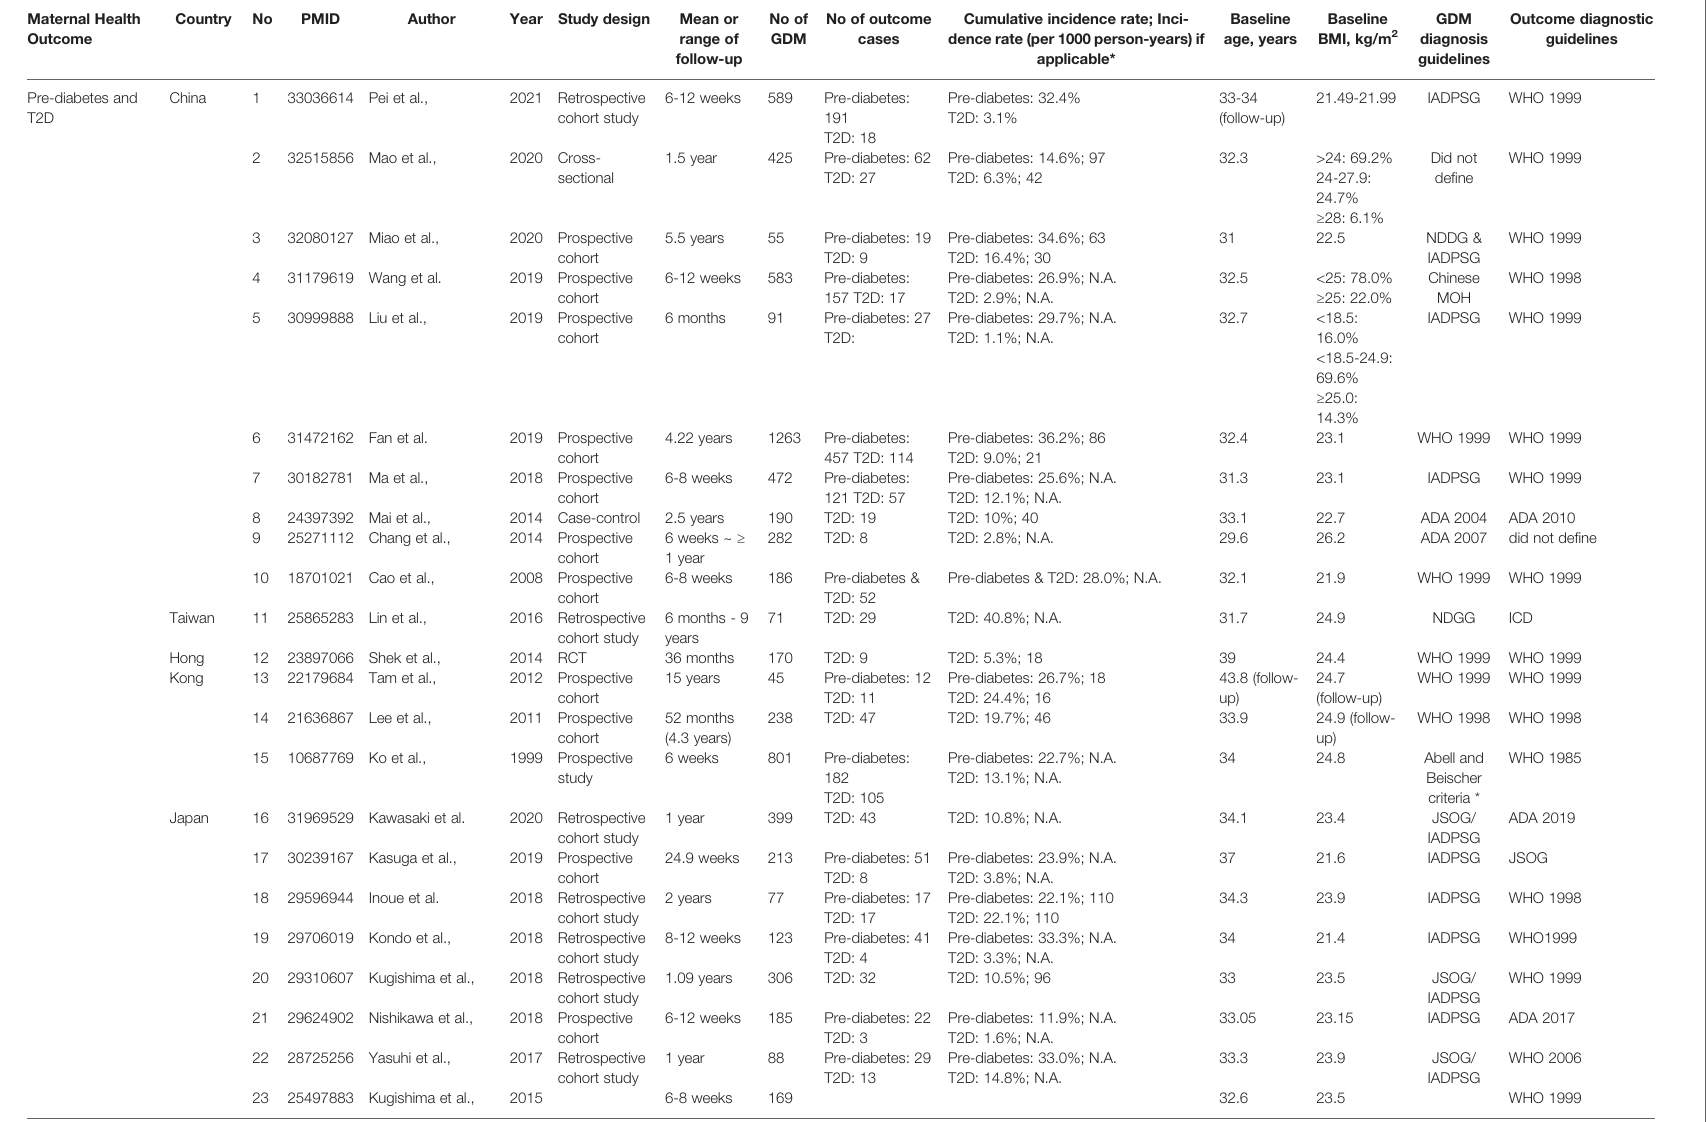
TABLE 1 | Summary of studies addressing GDM-related maternal health outcomes in Native Asians. Maternal Health Country No Outcome